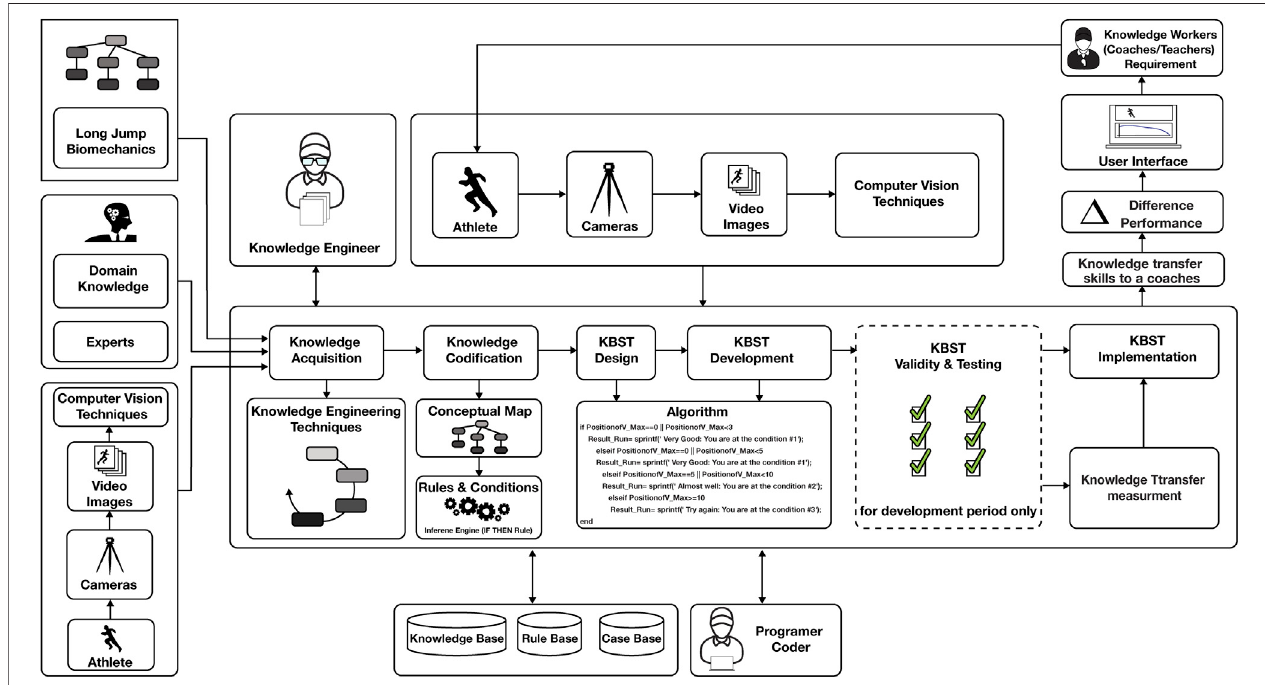
FIGURE 1 | The Knowledge-Based Smart Trainer system